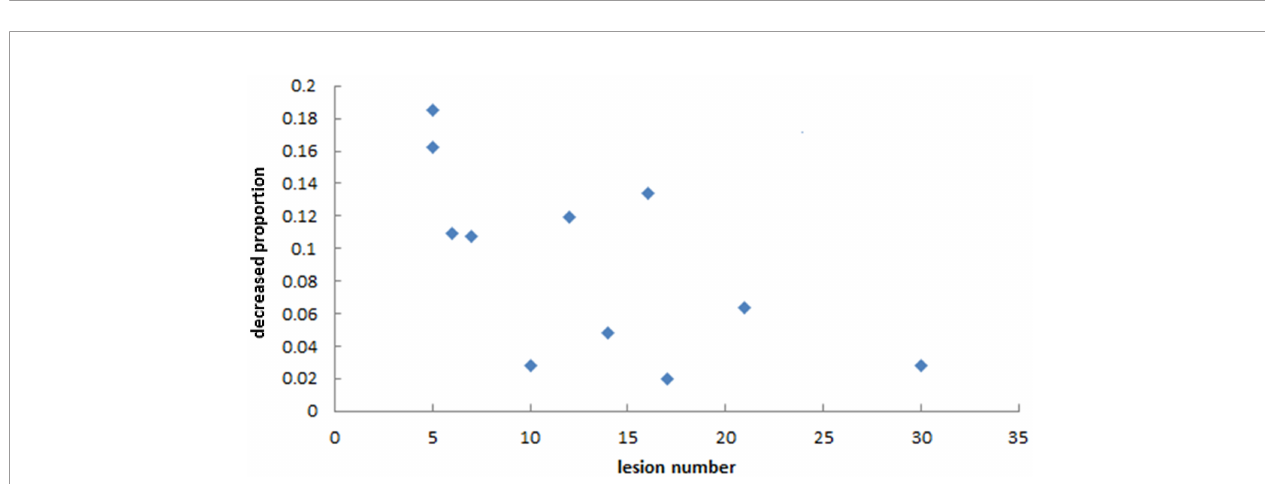
FIGURE 8 | The relationship between the decreased proportion of D mean of normal brain in LGS plans and the number of lesions. It seemed that the decreased proportions in the D mean value of normal brain tended to decrease with an increased number of lesions.